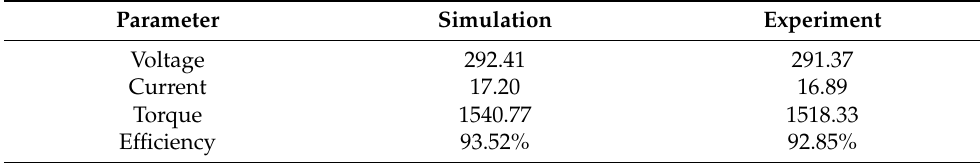
Figure 2. The process flow of obtaining the results. Table 2. Comparison of machine output parameters between healthy and